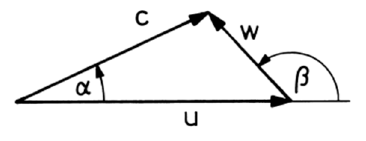
Figure 13. Velocity triangle.